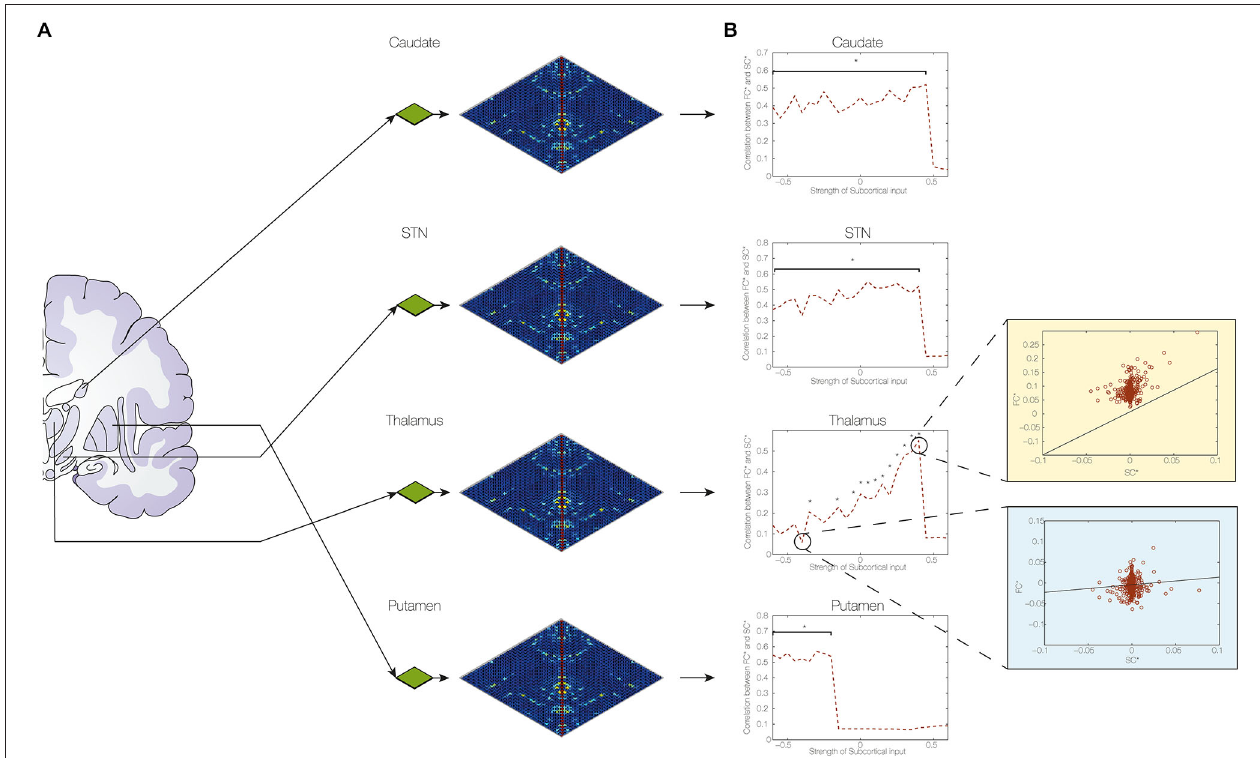
was highly significant ( p < 10 –7 ). (B) The figure clearly demonstrates the importance of the changes in connectivity weights to the thalamus and the putamen with the consequences of the best fit in thalamic connectivity shown in top right (light yellow) and poorest fit shown in bottom right (light blue) (with a star indicating significance levels of p <